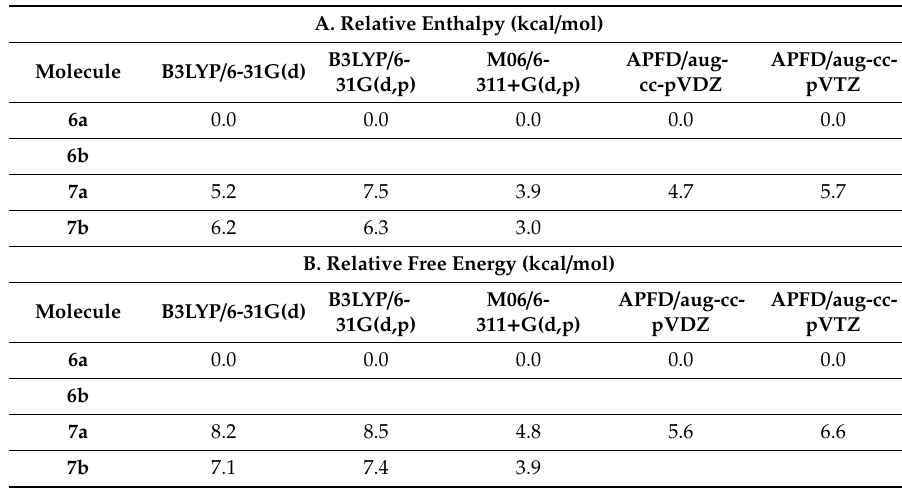
Table 1. Relative enthalpies and free energies of the four stereoisomers of 1-methylazepine ( 6a and 6b ) and 7-azanorcaradiene ( 7a and 7b ) as a function of computation methodologies (1.000 kcal = 4.184 kJ). In each column the lowest enthalpy or free energy value is set = 0.0 kcal / mol. (6a is lower in enthalpy than 6b and is easily converted to 6b ).